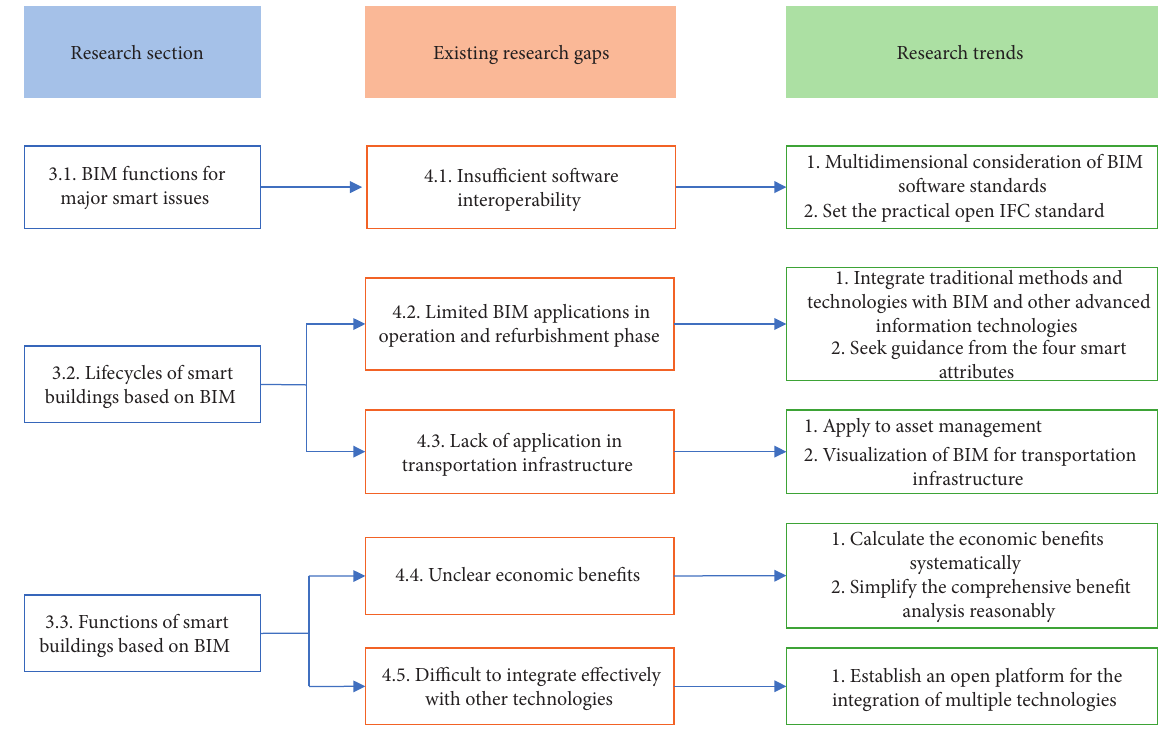
Figure 8: Research framework linking existing study areas to future